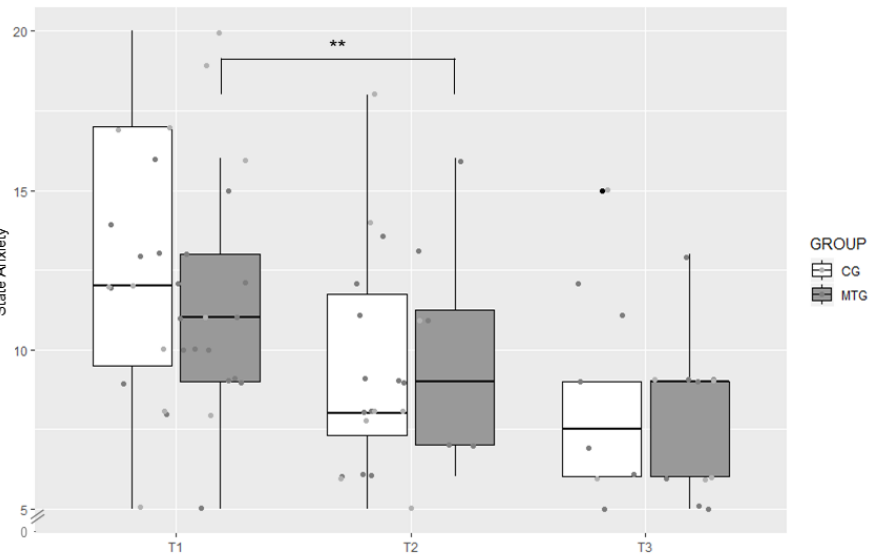
Figure 2. Boxplot of state anxiety levels in the music therapy group (MTG) and the control group (CG) measured at T1, T2, and T3 with the German short form of the state version of the State-Trait Anxiety Inventory, ** p < 0.01.